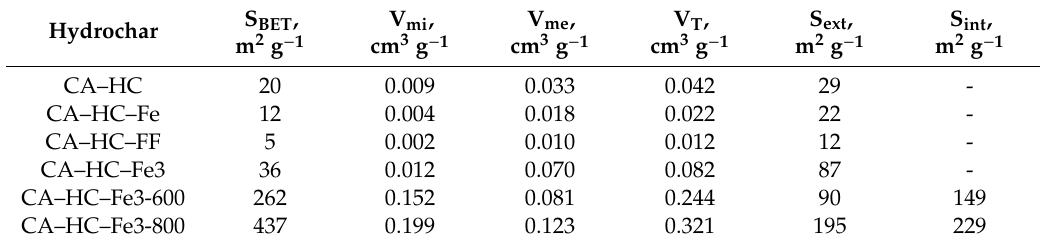
Table 3. Textural parameters of the HCs as deduced from N 2 adsorption at − 196 ◦ C.